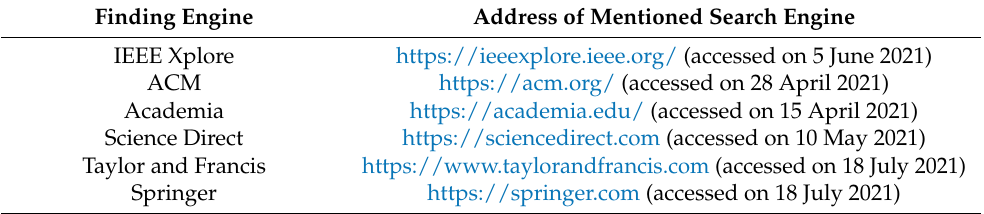
Table 1. Choice of search engine.